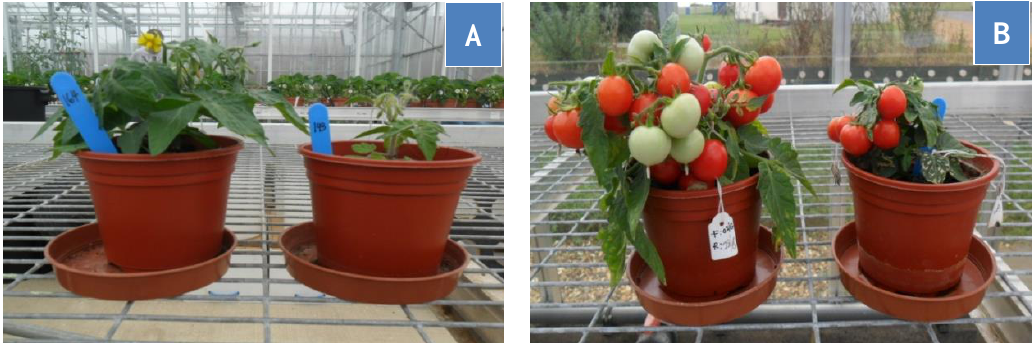
Figure 5. Growth of Micro-Tom tomatoes in pots containing crude oil at 0 mg/kg TPH (left plant) and 5000 mg/kg TPH (right plant), before fruiting ( A ) and during ripening ( B ). Source: Odukoya [5].